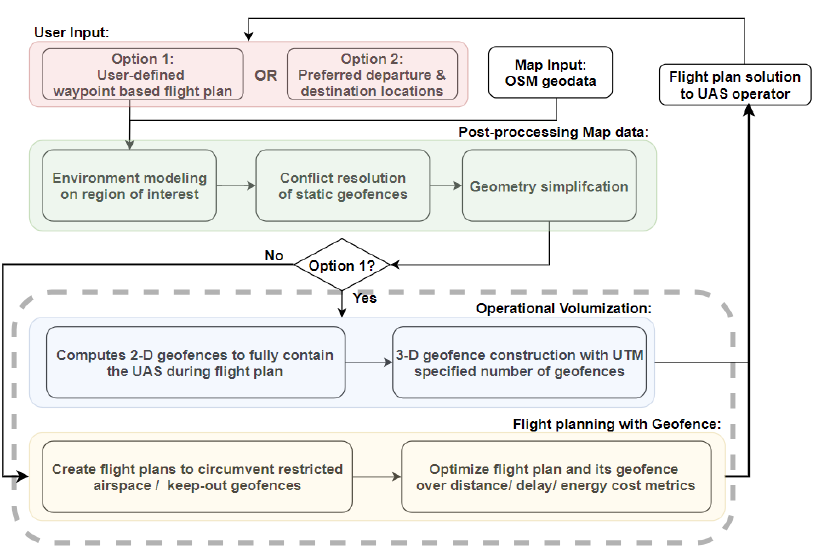
Figure 2. Airspace and environment geofencing functionality and data